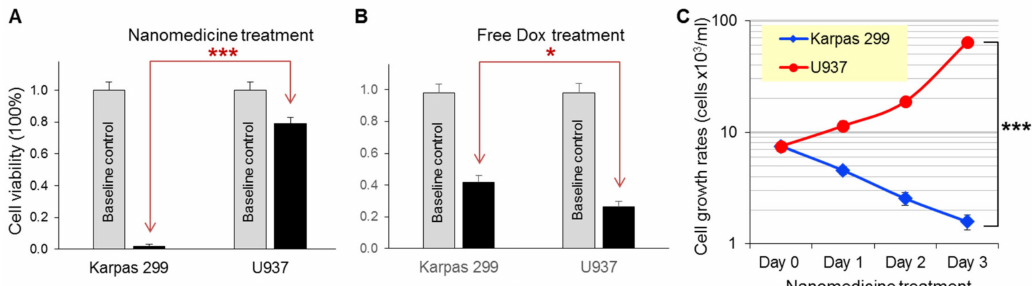
Figure 7. Precision therapeutic e ff ects of protamine nanomedicine. ( A ) Lymphoma cells were treated with the protamine nanomedicine (1 µ g / mL) or vehicle alone for baseline control for three days. Cell viability assays showed a 98.5% death rate of Karpas 299 cells versus a 21% death rate of U937 cells under the same treatment conditions. ( B ) In contrast, treatments with the same amount of free Dox drug (1.2 µ M) non-discriminatingly killed both Karpas 299 and U937 cells, with more toxicity to U937 cells. ( C ) Cell growth analysis demonstrated the precision cancer therapy potential of the protamine nanomedicine, e ff ectively killing Karpas 299 cells and having no significant e ff ect on the growth of o ff -target U937 cells under the same treatment conditions. The data shown represent mean ± SD, n = 3 independent experiments; * p < 0.05, *** p <